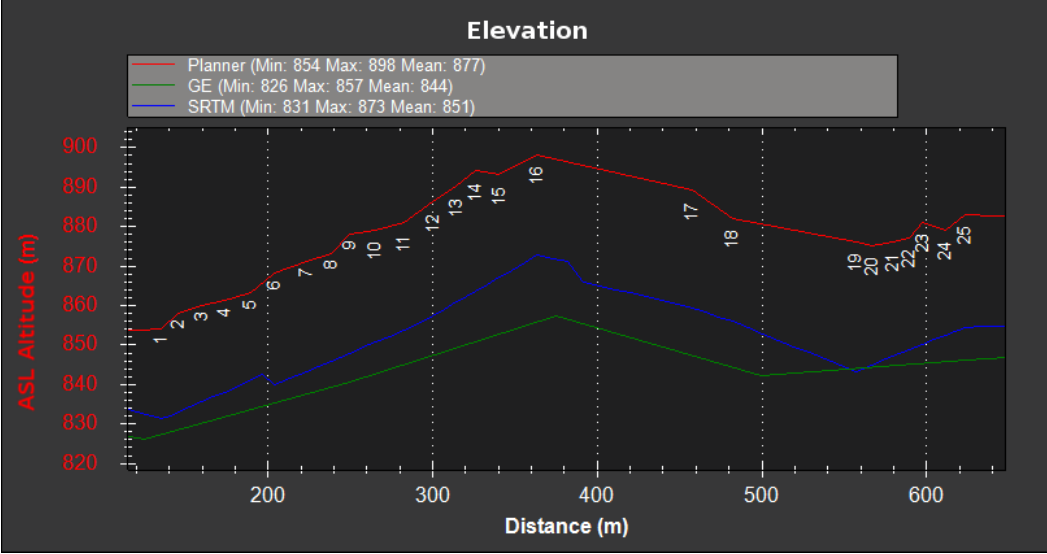
Figure 9. Hill flight elevation. The figure shows the elevation at the specified coordinates provided by the flight plan (25 m above ground), Google Earth (GE) and the Shuttle RADAR Topography Mission (SRTM) databases. This graph was generated with the Mission Planner Ground Control Station